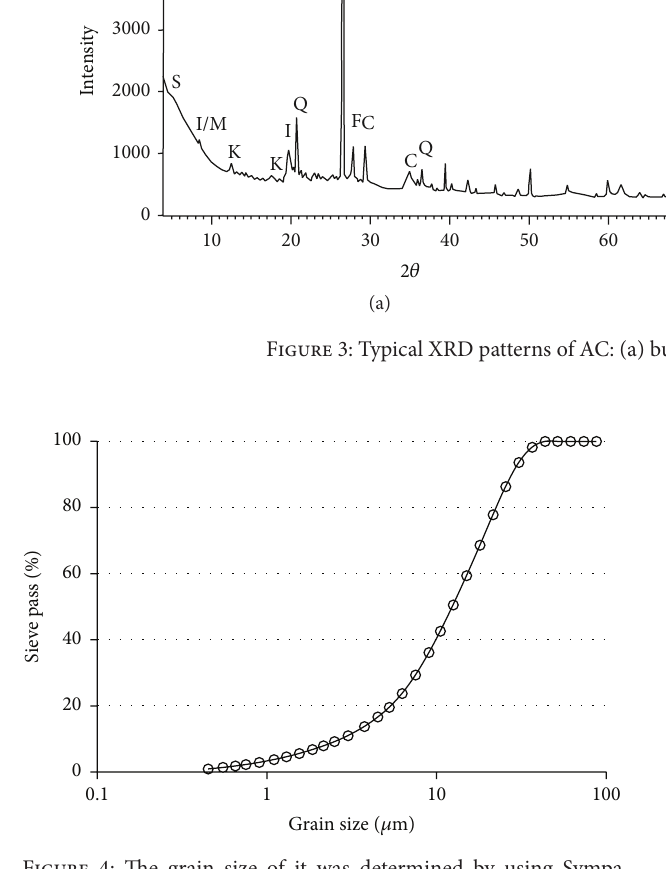
Figure 4: The grain size of it was determined by using Sympa Technology Laser Grain Size Analyses System.